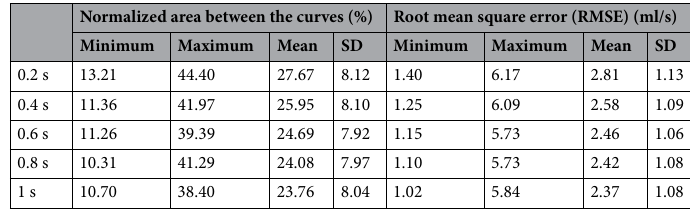
Table 3. Comparison between the UF and SUF flow rate curves. SD standard deviation.